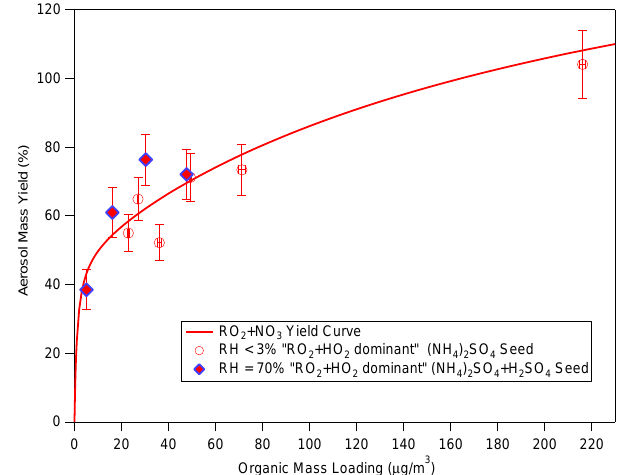
Figure 3. Aerosol mass yield as a function of organic mass load- ing for the β -pinene + NO 3 reaction under “RO 2 + NO 3 dominant” conditions. The aerosol mass yields obtained in this study are com- pared to those measured in previous chamber studies by Griffin et al. (1999) and Fry et al. (2009). The aerosol mass yields obtained in this study are fitted using the two-product model proposed pre- viously by Odum et al. (1996). The yield parameters obtained in this study and those from Griffin et al. (1999) are shown in Table 2. In order to better compare the aerosol mass yields obtained in this study to that by Griffin et al. (1999), measurements by Griffin et al. (1999) are adjusted to a temperature of 298K and density of 1.41gcm − 3 . The x axis error bars represent 1 standard deviation of volume measured by SMPS at peak growth. The y axis error bars represent uncertainty in yield calculated by an 8% uncertainty in chamber volume, 5% uncertainty in hydrocarbon injection, and 1 standard deviation of the aerosol volume measured by SMPS at peak growth.